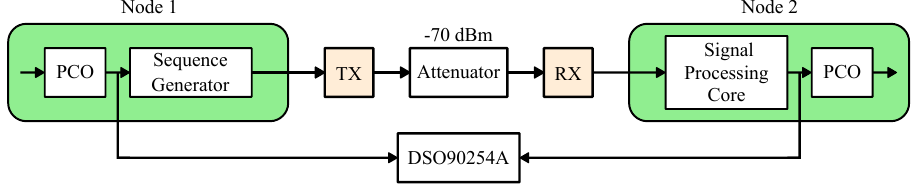
Figure 19. Measurement setup to quantify the limits of duty-cycling (Figure